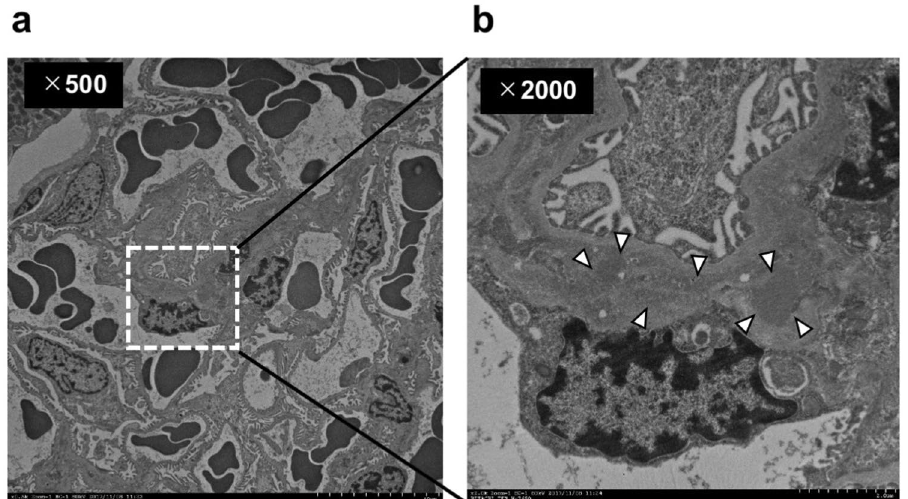
Figure 7. Representative appearance of kidney tissue by transmission electron microscopy in rats inoculated with S. mutans . ( a , b ) Representative appearance of the kidneys of rats inoculated with S. mutans . White arrows indicate electron dense deposits